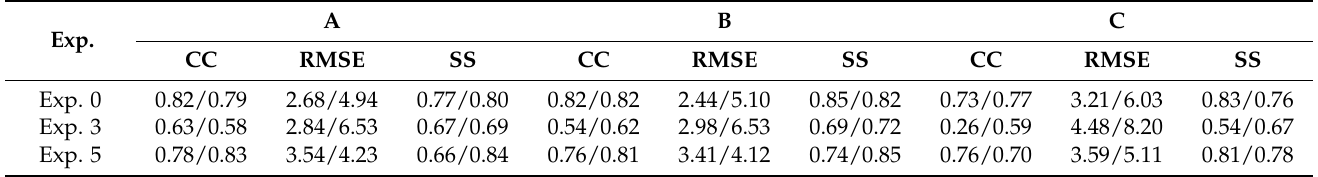
Table 4. Model validation statistics of salinity obtained from Exp. 0, 3, and 5 at the observational sites (value at surface layer/value at bottom